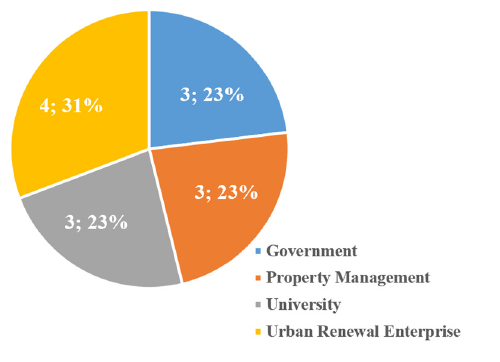
Figure 3. The preliminary classification of indicators.